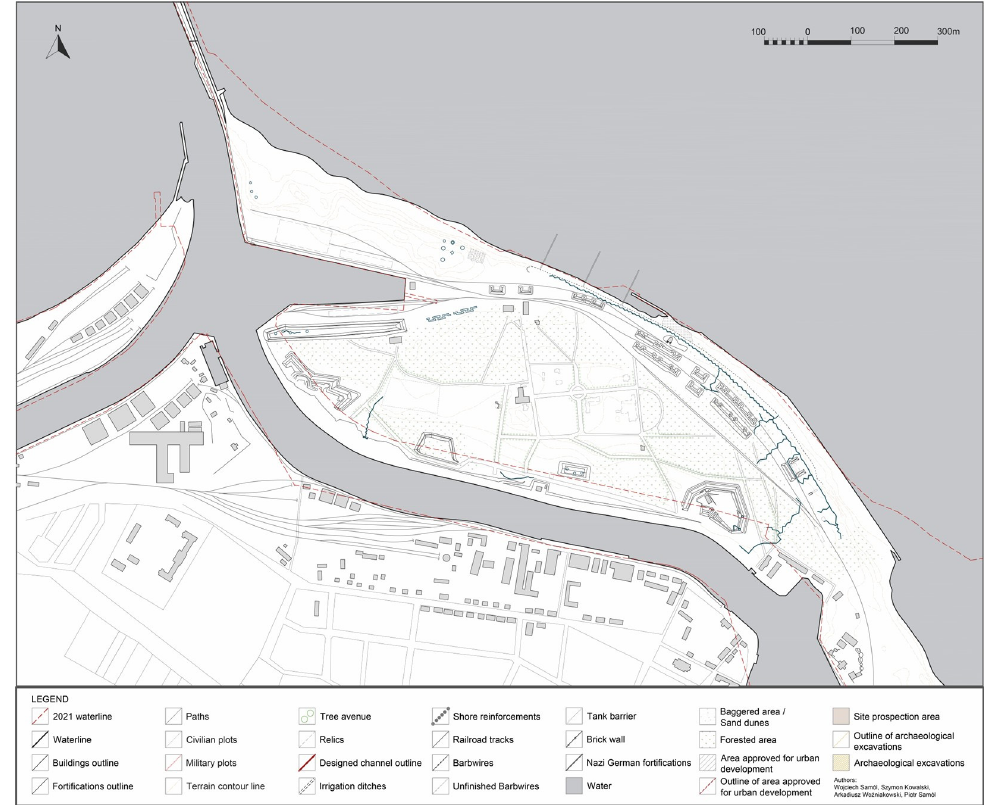
Figure 11. Westerplatte in 1945 with Nazi German Fortifications and dismantled resort